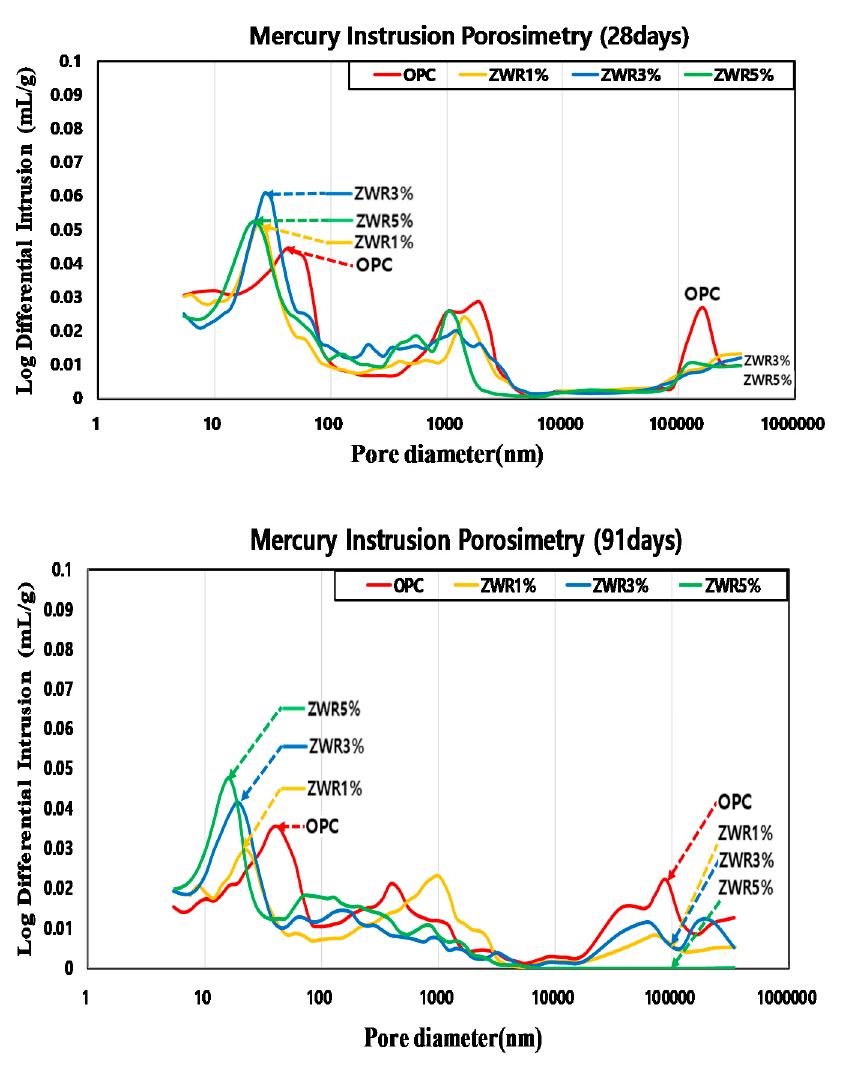
Figure 9. Results of MIP graph (28, 91 days).